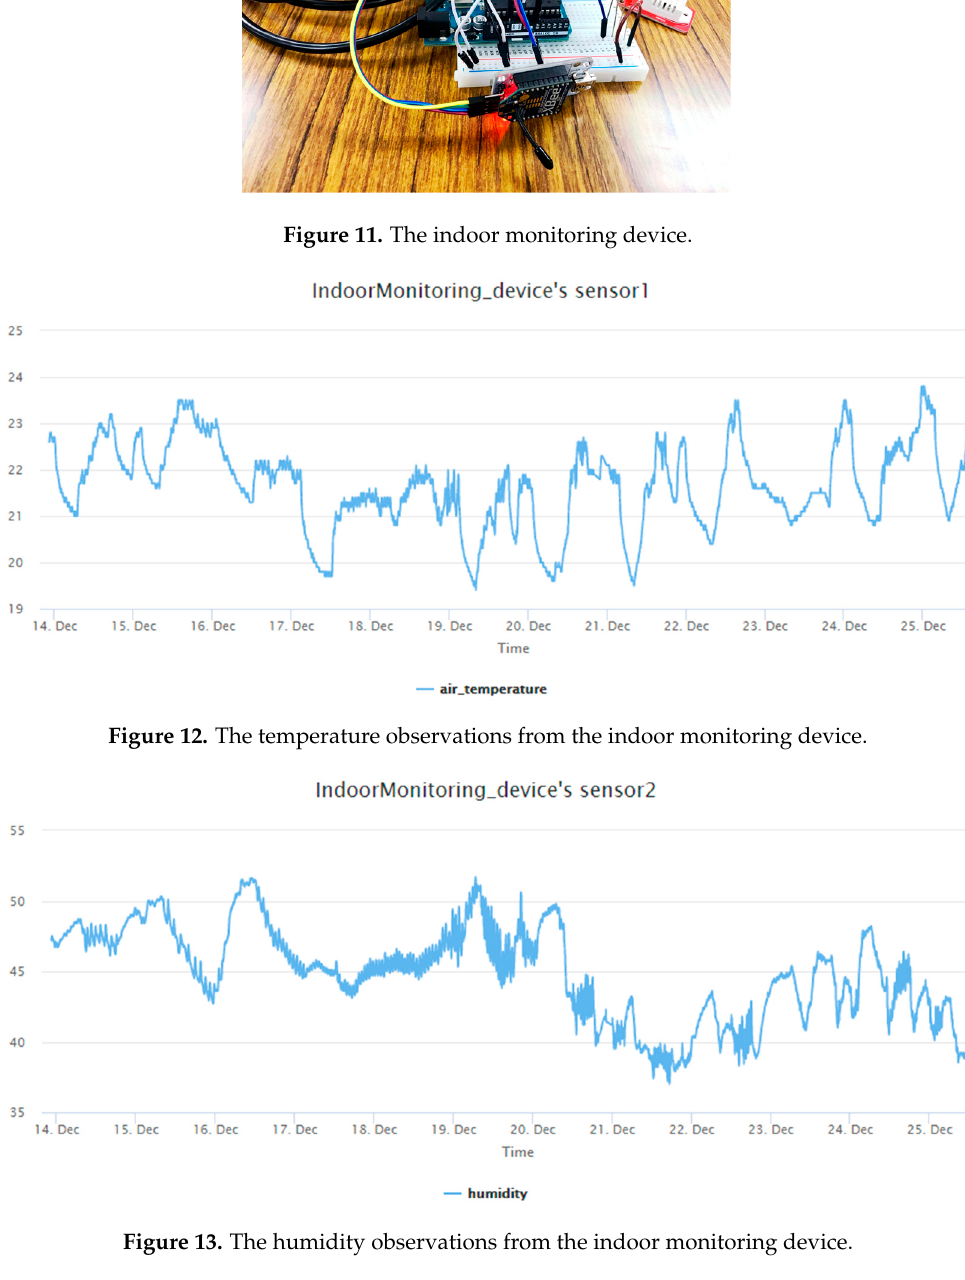
Figure 13. The humidity observations from the indoor monitoring device.